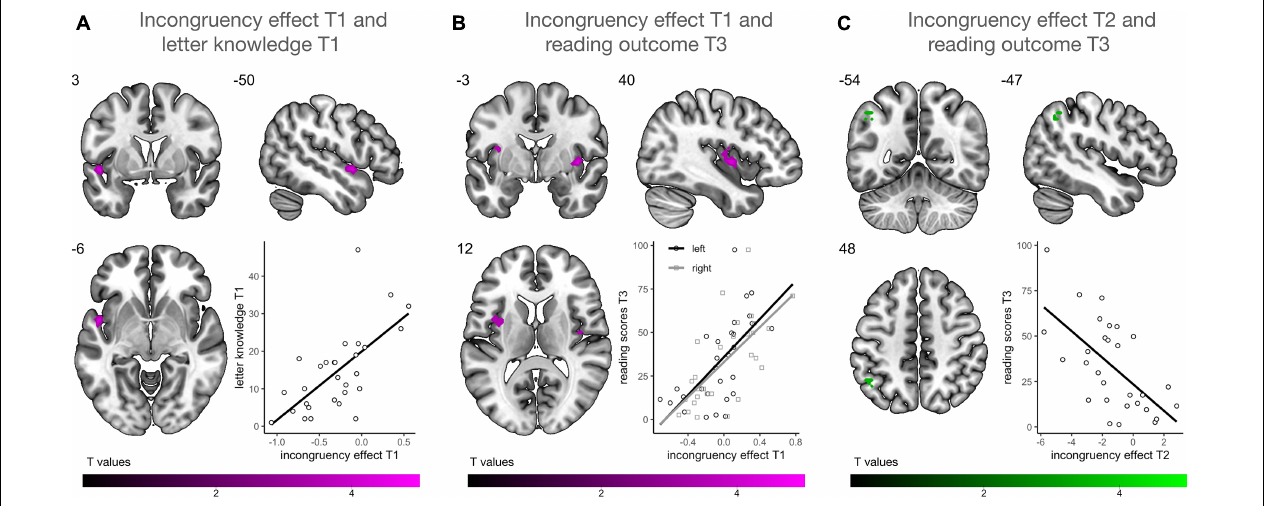
FIGURE 5 | Multiple regression analysis ( n = 29). (A) Higher activation for incongruent than congruent letter-speech sound pairs in the left anterior superior temporal gyrus (STG)/planum polare at T1 was associated with higher letter knowledge at T1. (B) Higher activation for incongruent than congruent letter-speech sound pairs bilaterally in the left STG and insula at T1 was associated with higher reading fluency scores at T3. (C) Higher activation for incongruent than congruent letter-speech sound pairs in the left angular gyrus at T2 was associated with lower reading fluency scores at